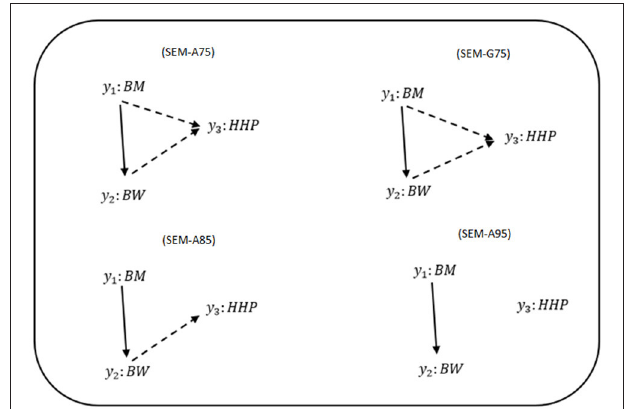
FIGURE 1 | Causal graphs inferred using the IC algorithm among three traits: breast meat (BM), body weight (BW), and hen-house production (HHP) in the chicken data. SEM-A75 and SEM-G75 were the inferred fully recursive causal structures with HPD > 0.75 and corrected for genetic confounder using A (pedigree-based) and G (marker-based) matrices. SEM-A85 and SEM-A95 were obtained with HPD > 0.85 and HPD > 0.95, respectively, corrected with A. Arrows indicate direction of causal relationships. Dashed lines indicate negative coefficients, and the continuous arrows indicate positive coefficients.